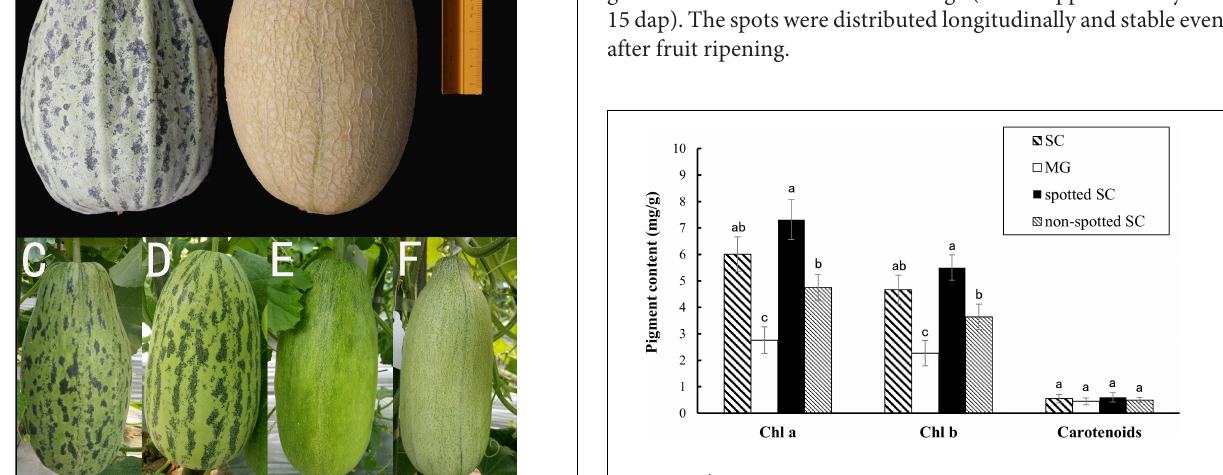
FIGURE 2 | Pigment contents analysis. Contents of chlorophyll and carotenoids in the 15-dap peels of two parental lines, SC and MG. All data are shown as mean ± SD of three replicates. Different letters indicate significant difference (Duncan’s multiple range test, p < 0.05). Spotted SC, spotted part of SC peel; non-spotted SC, non-spotted part of SC peel; Chl a , chlorophyll a ; Chl b , chlorophyll b